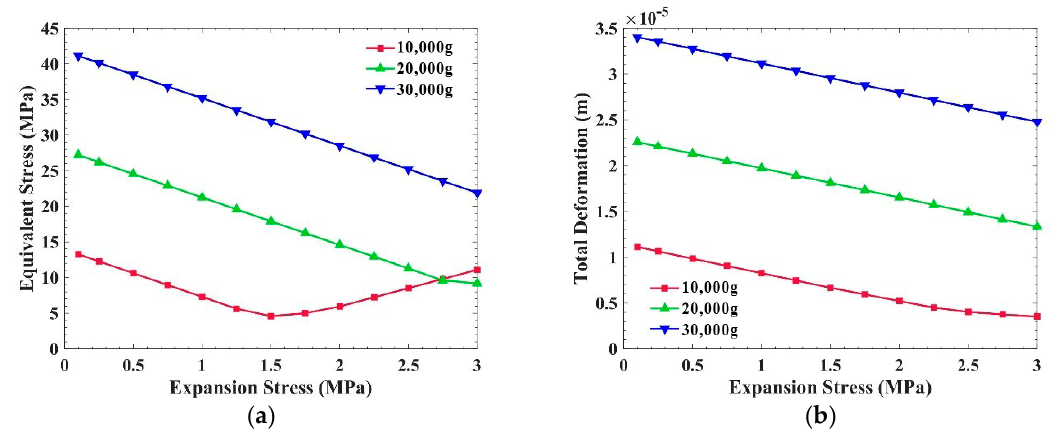
Figure 8. Influence of expansion stress on the PCB, which is perpendicular to the overload direction: ( a ) Equivalent stress of the PCB; ( b ) Total deformation of the PCB.